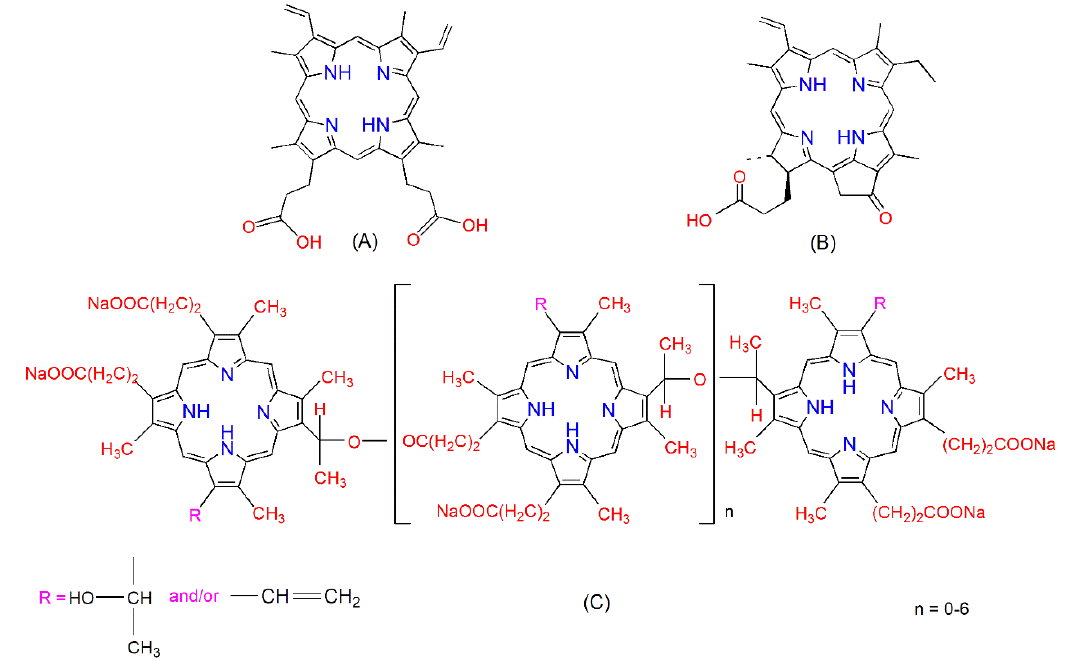
Figure 1. Chemical structures of protoporphyrin IX (PpIX) ( A ), pyropheophorbide-a (PPa) ( B ), and Photofrin ® ( PF) ( C ).